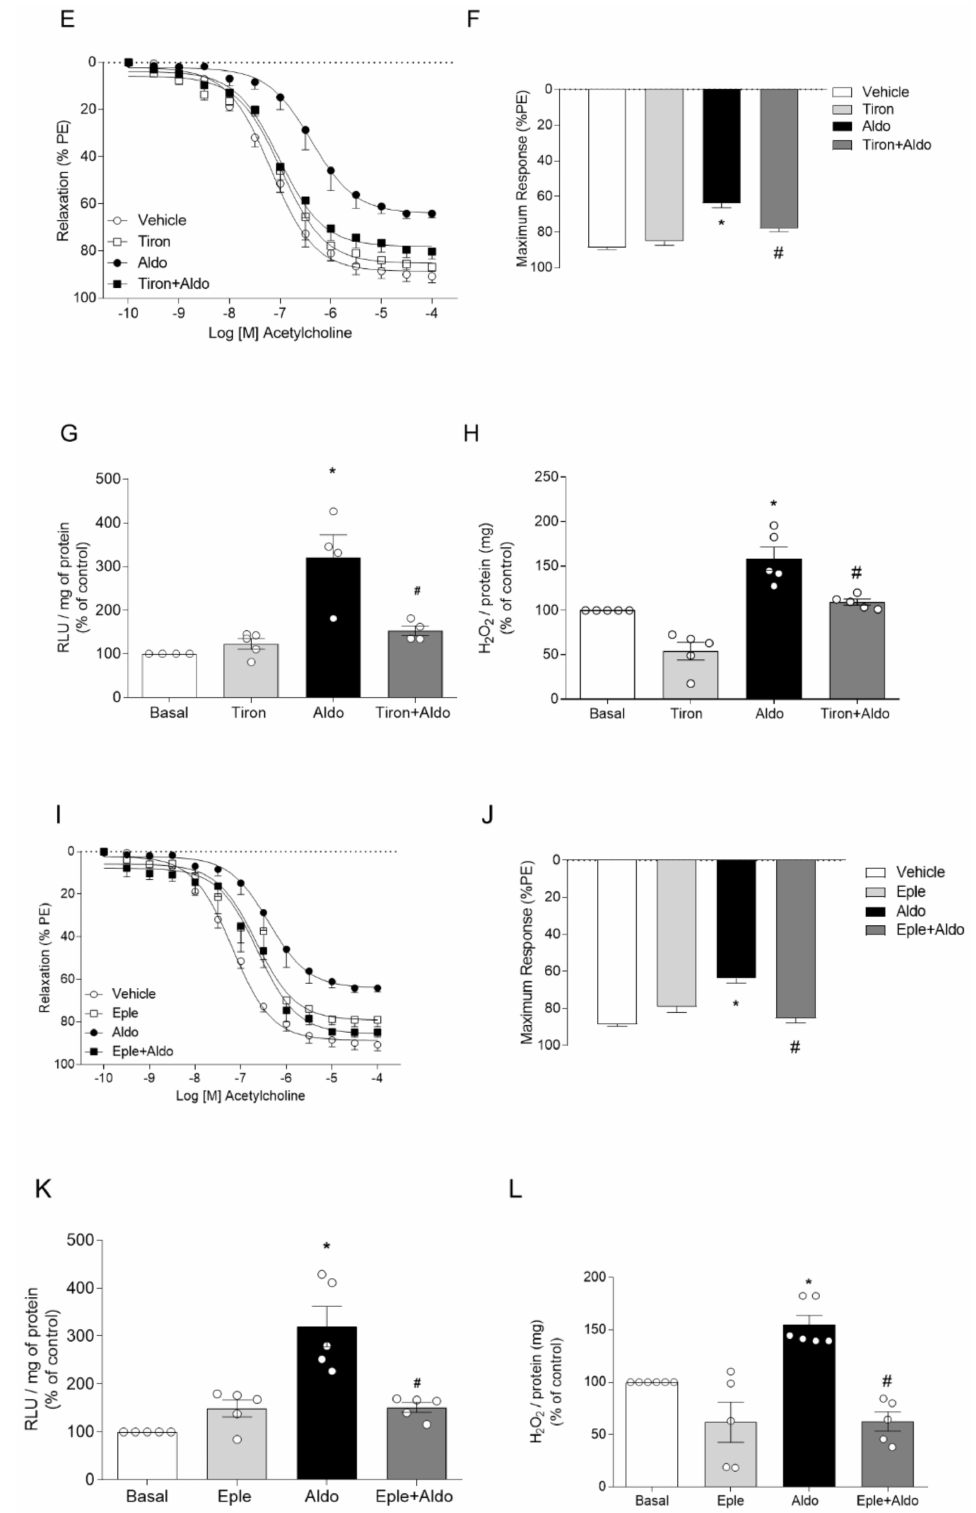
Figure 1. Aldosterone, via MR activation, induces vascular dysfunction and oxidative stress. Concentration-effect curves ( A , E , I ) and maximum responses ( B , F , J ) to acetylcholine in the tho- racic aortas of male C57BL/6J mice. Superoxide anion ( C , G , K ) and hydrogen peroxide ( D , H , L ) generation. Experiments were performed in the presence of Aldo (100 nM for 30 min) plus vehicle, tiron (ROS scavenger, 100 µ M for 30 min), or Eple (MR antagonist, 1 µ M for 30 min). Data represent the mean ± SEM. One-way ANOVA: *, p < 0.05 vs. basal; #, p <0.05 vs. Aldo; n = 5–9 for each experimental